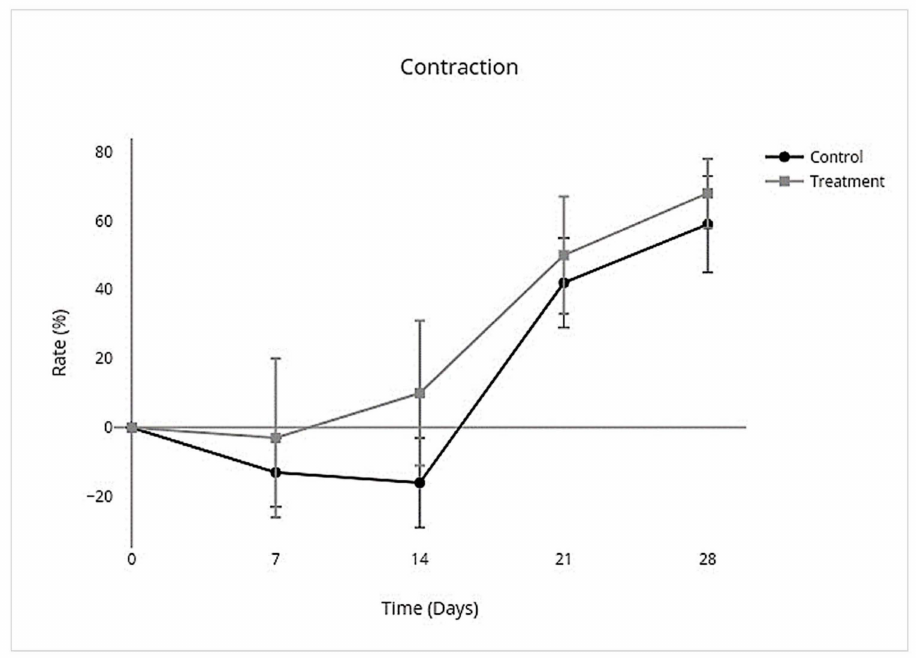
Figure 6. Total area (%) of contraction contributing to wound closure of limb wounds. There was an overall increase in total contraction over all days with no significant treatment effect on individual days.